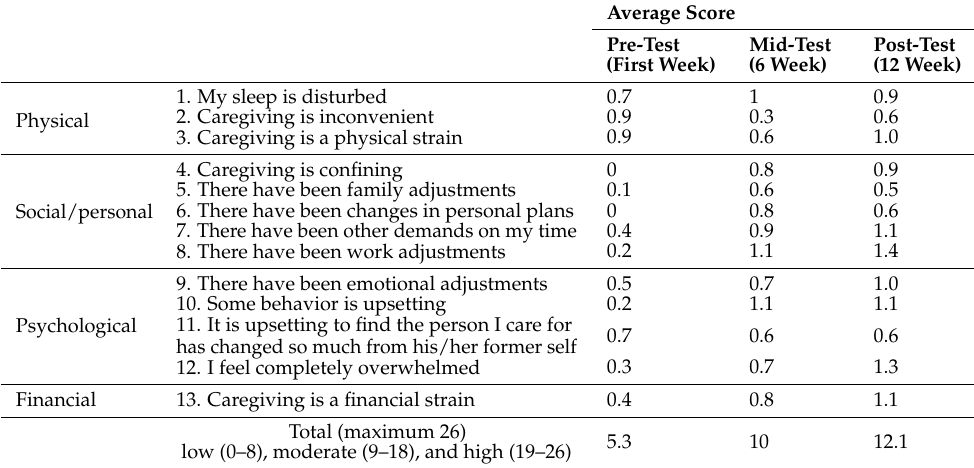
Table 3. The modified caregiver strain index of